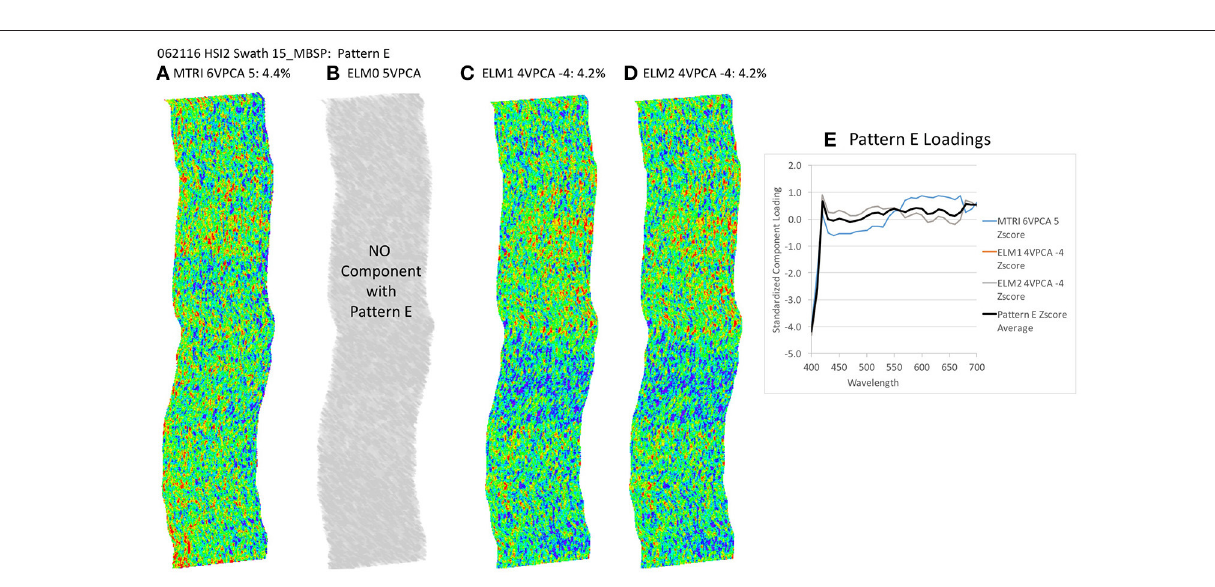
FIGURE 12 | Spatial distribution of varimax-rotated principal component analysis (VPCA) component pattern E. (A) Michigan Tech Research Institute (MTRI) correction method decomposition. (B) Empirical Line Method 0 (ELM0) correction method decomposition. (C) Empirical Line Method 1 (ELM1) correction